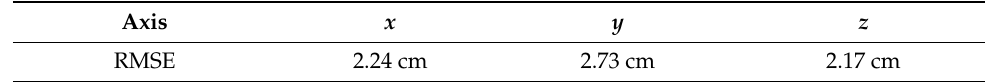
Table 3. Root mean square error (RMSE) of MLSS-VO.